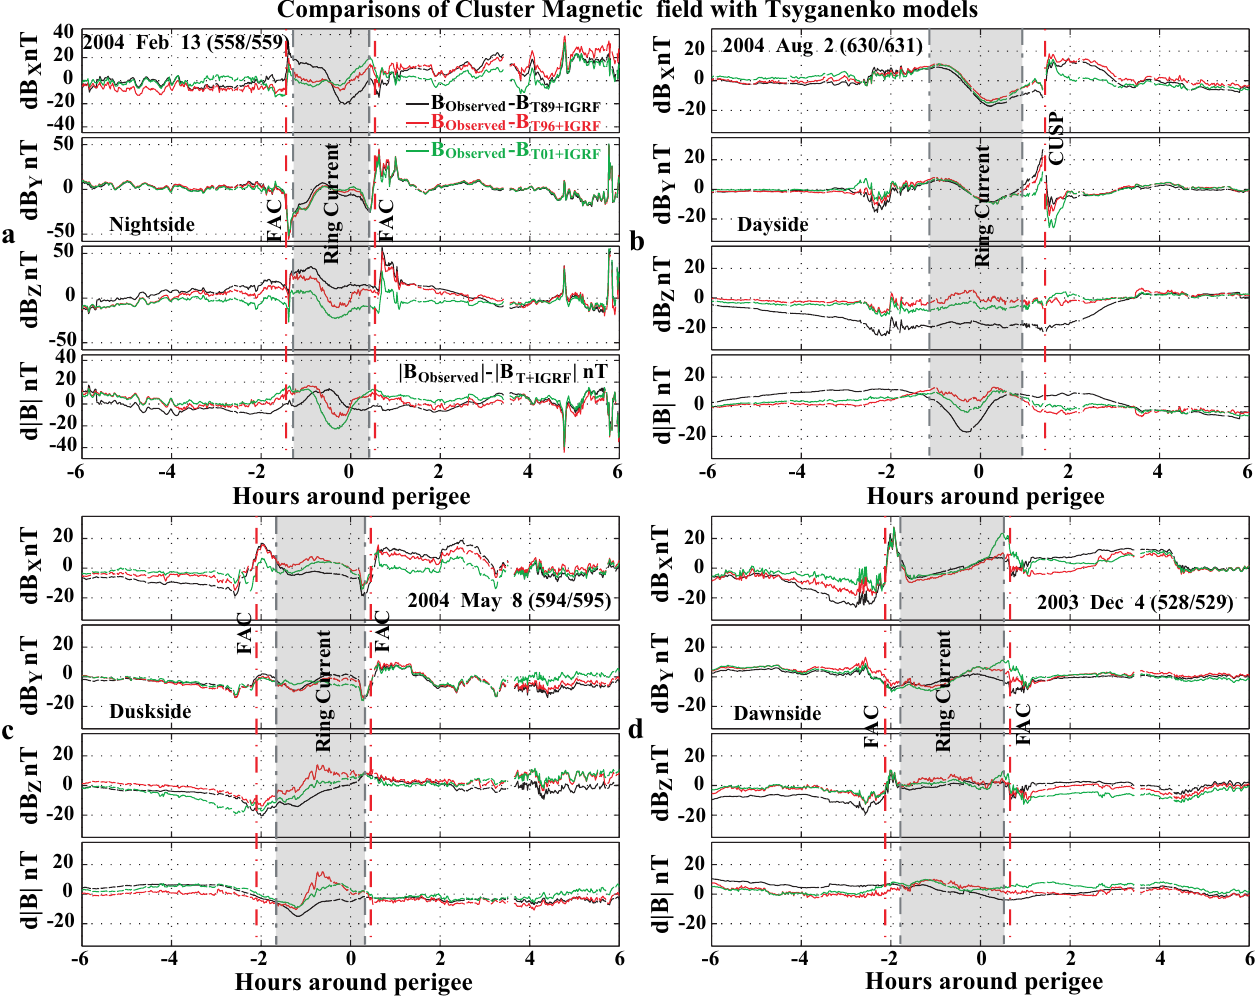
Fig. 4. Residuals from the comparisons of Cluster S/C 1 observations with T89 (black), T96 (red) and T01 (green) and IGRF (magenta) models for the nightside pass on 13 February 2004 (a) , dayside pass on 2 August 2004 (b) , duskside pass on 8 May 2004 (c) and dawnside pass on 4 December 2003 (d) . From top to bottom panels of Fig. 5a–d are for the dB XGSM , dB YGSM , dB ZGSM and the magnitude of the field. The black vertical lines show the ring current region